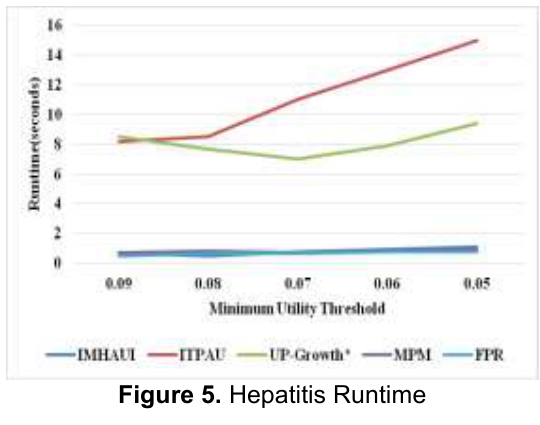
Figure 5. Hepatitis Runtime